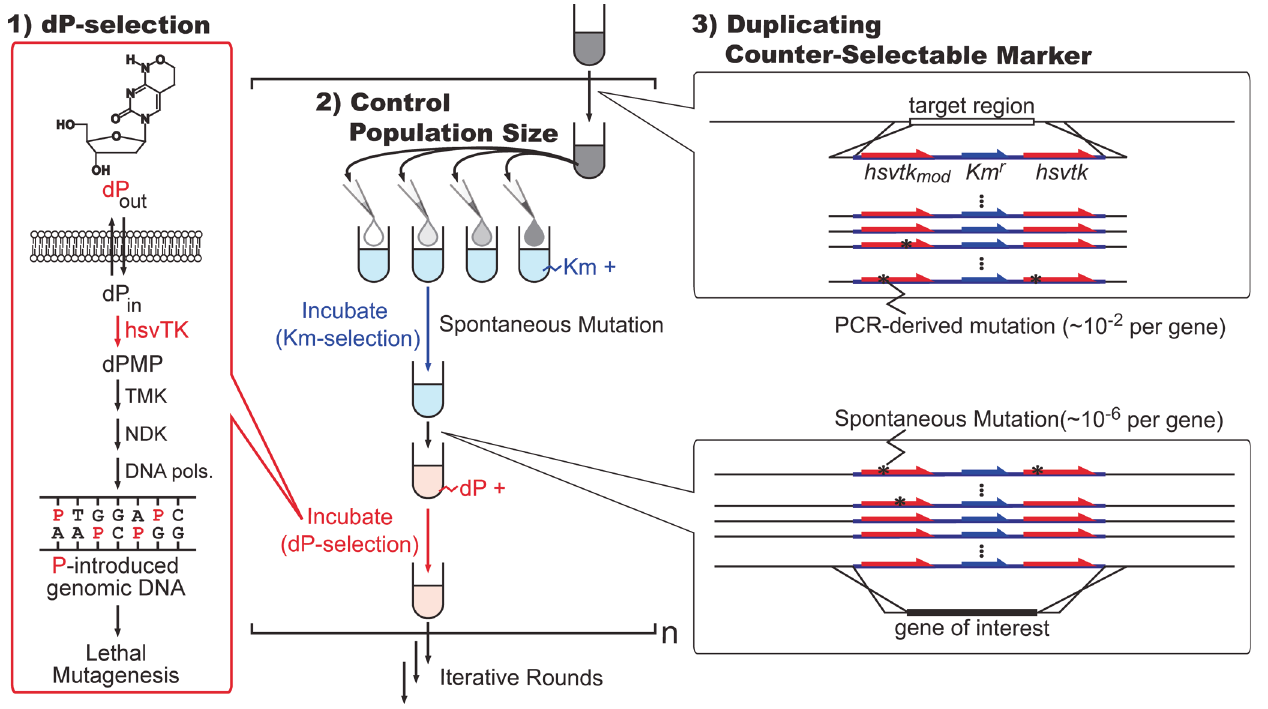
Fig 1. The recombineering protocol adapted for multiple rounds. First, the dP kinase activity of hsvTK is used for rapid and efficient counter-selection in liquid media. The mechanism of action of dP-selection is shown in the left panel. Second, the number of clones to be transferred between the steps is limited by diluting/aliquoting the transformant cultures, to prevent the propagation and subsequent domination of clones with PCR-generated inactivating mutations. Finally, the gene coding for hsvtk was duplicated to drastically reduce the emergence of selection escapes. TMK: thymidylate kinase, NDK: nucleoside diphosphate kinase, DNA pols: DNA polymerases, Km: